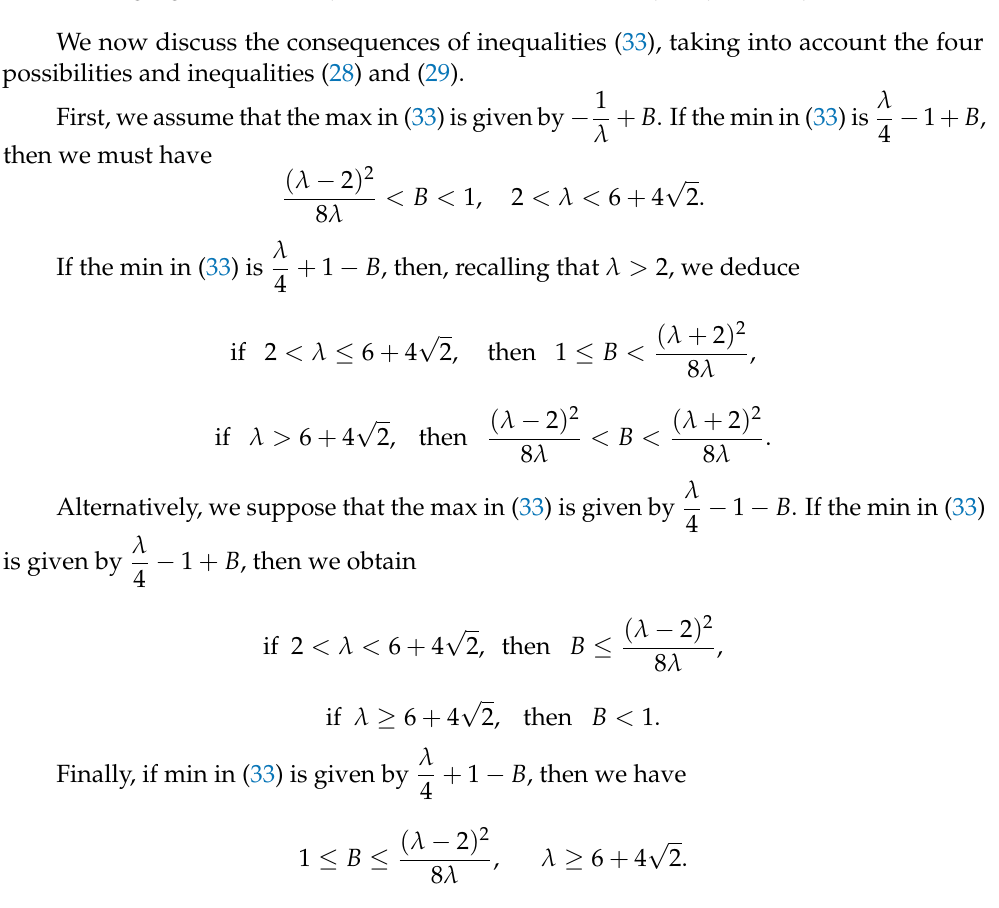
Figure 3. Plug regions in Case 2 ; y 0 < 0 and if − B < C 0 < B then y 0 < y 1 < 0 < y 2